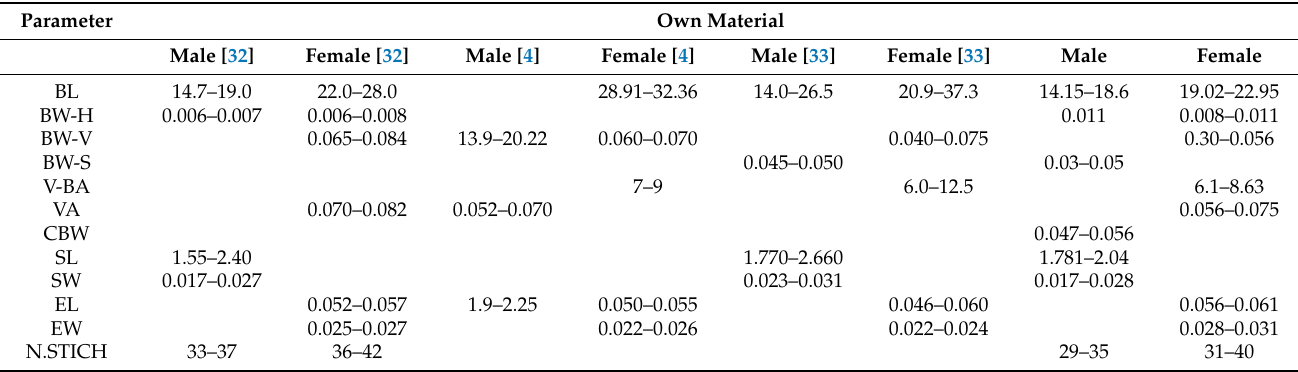
Table 2. Morphometric characteristics of nematodes Capillaria phasianina. Measurements are given in mm. Ranges of measurements reported by other authors are compared with our own results.